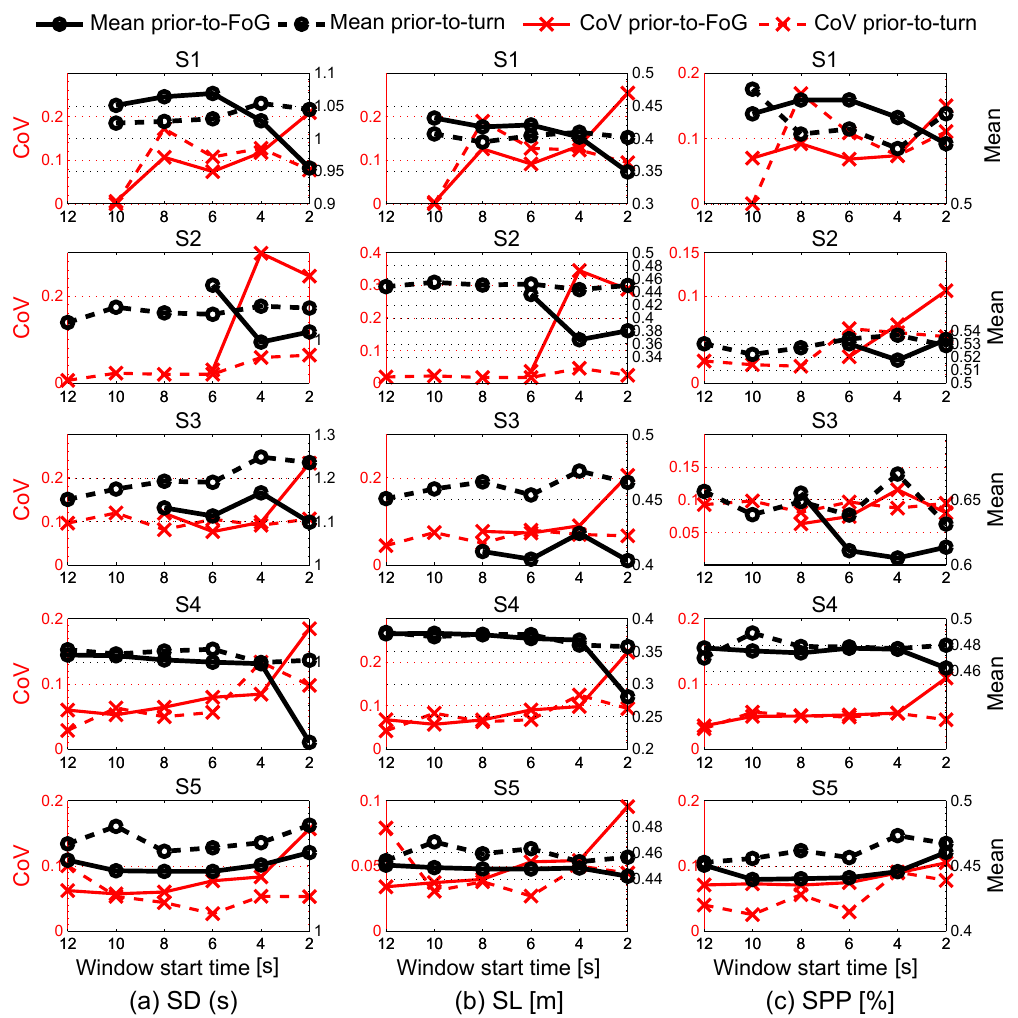
Figure 5: The mean and CoV values in case of stride duration, stride length, and stance phase percentage for the two different types of walking sessions, in each of the 5 subjects data. The numbers of the time axis represent the time difference between the start of FoG and the start of the window from which features were computed. For example, 2 seconds means that features were computed in the data window that started with 2 seconds prior-to-FoG, 4 seconds – in the window which started with 4 seconds prior to FoG, and so